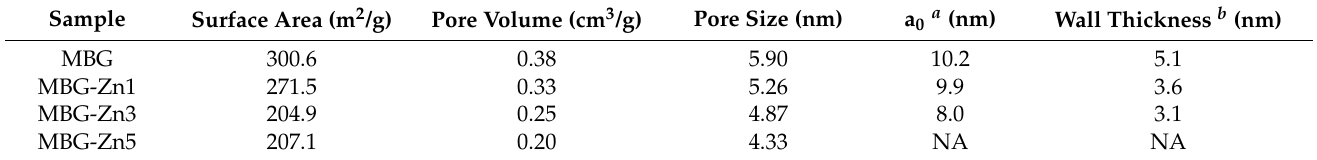
Table 2. Textural properties calculated by nitrogen adsorption analysis.